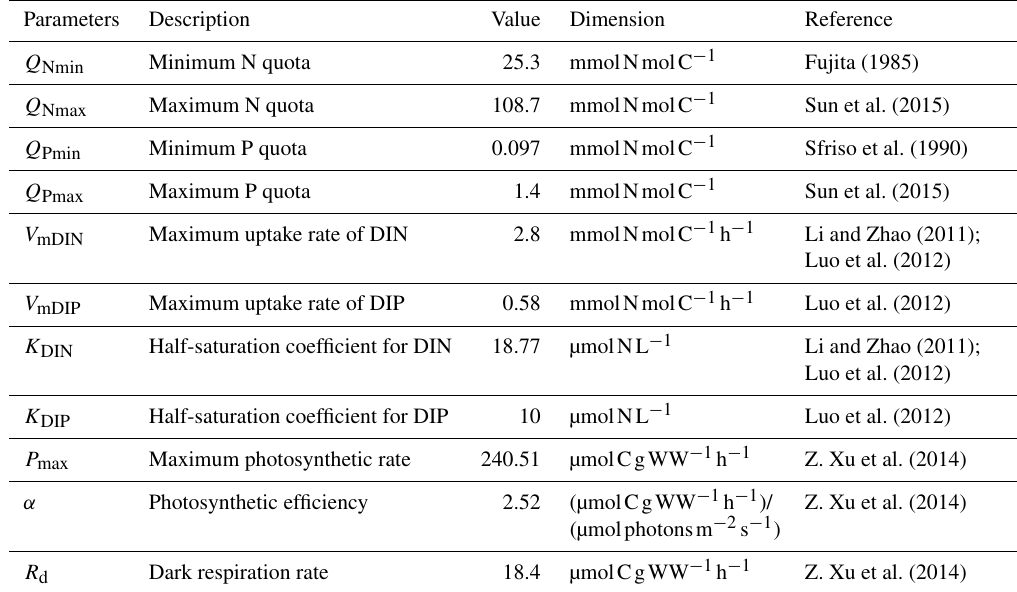
Table 1. Parameters used in the ecological module for U. prolifera , modified from Sun et al. (2020).